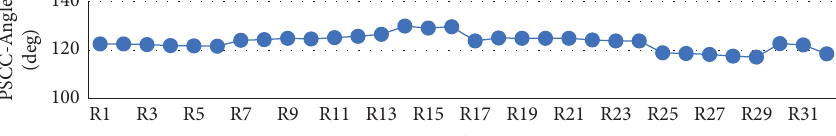
Figure 10: PCSS angle values when LG fault occurs on S16 (case 1).